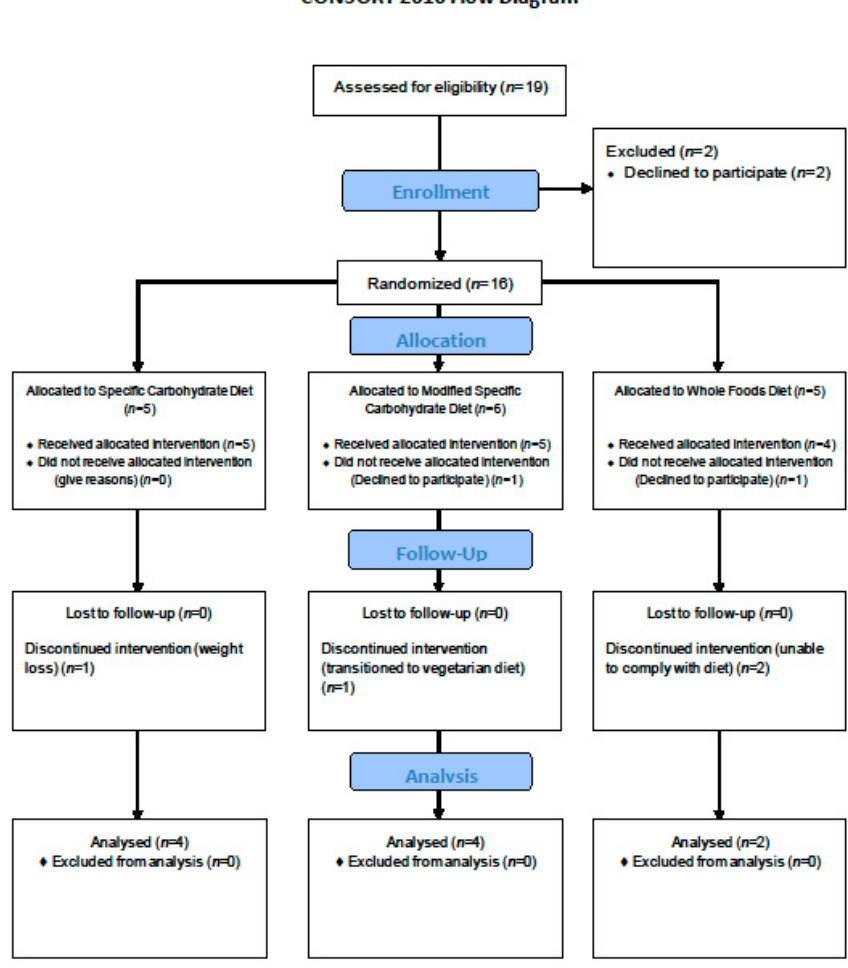
Figure 2. Consort Flow